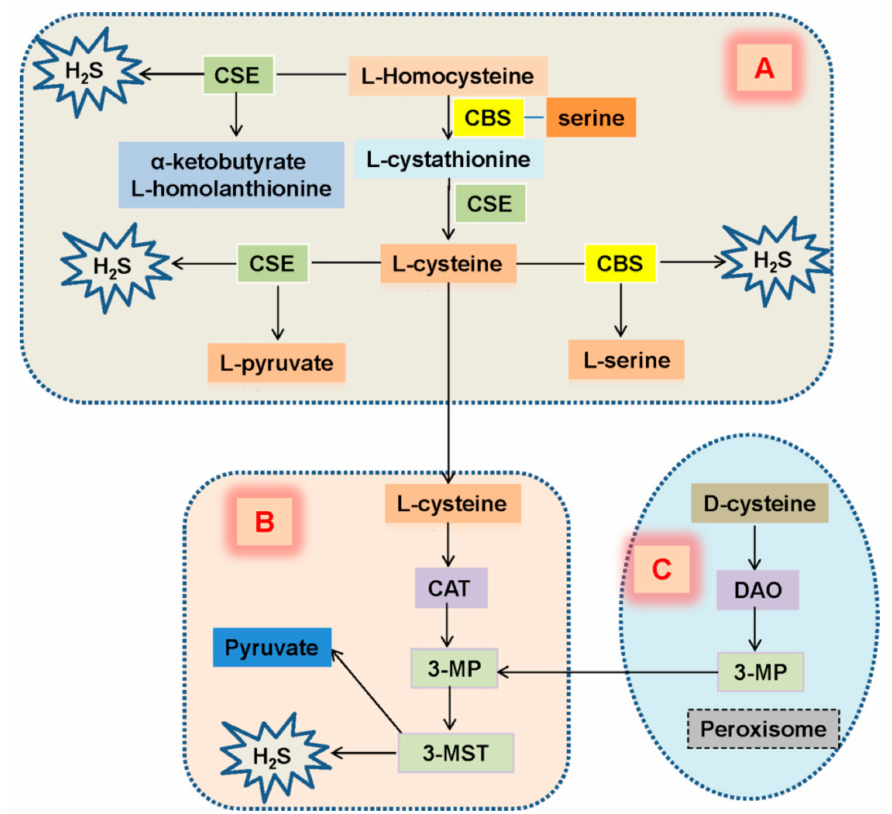
Figure 2. Endogenous synthesis of H 2 S in renal system. ( A ) CSE reacts with L-homocysteine to induce H 2 S generation accompanied by formation of α -ketobutyrate and L-homolanthionine. CBS catalyzes L-homocysteine that leads to the production of L-cystathionine, which is converted into L-cysteine by CSE. The presence of L-cysteine serves as a substrate for generation of H 2 S by CBS and CSE. ( B ) L-Cysteine translocates to mitochondria, followed by conversion to 3-MP by CAT. 3-MST produces H 2 S generation from 3-MP. ( C ) Peroxisome-mediated generation of 3-MP from D-cysteine with the aid of DAO. 3-MP is then imported into the mitochondria and becomes a substrate for 3-MST to generate H 2 S. CBS,cystathionine β -synthase; CSE,cystathionineg-lyase; 3-MST,3-mercaptopyruvatesulfurtransferase; CAT, cysteine aminotransferase; DAO, D-amino acidoxidase; 3-mercapto pyruvate,